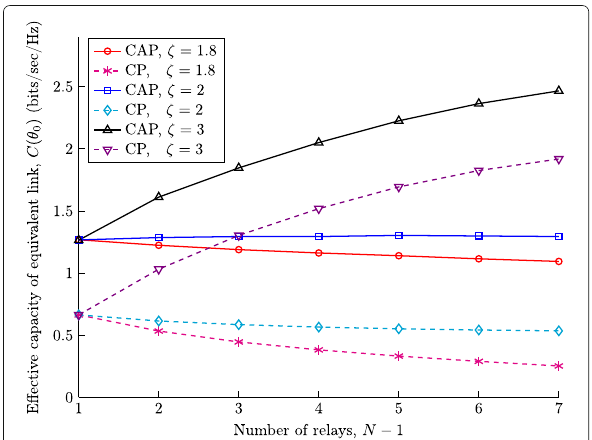
Fig. 4 Effect of increasing the number of relays, when the length of line of sight path is fixed and total transmission power is fixed for different path loss exponents,